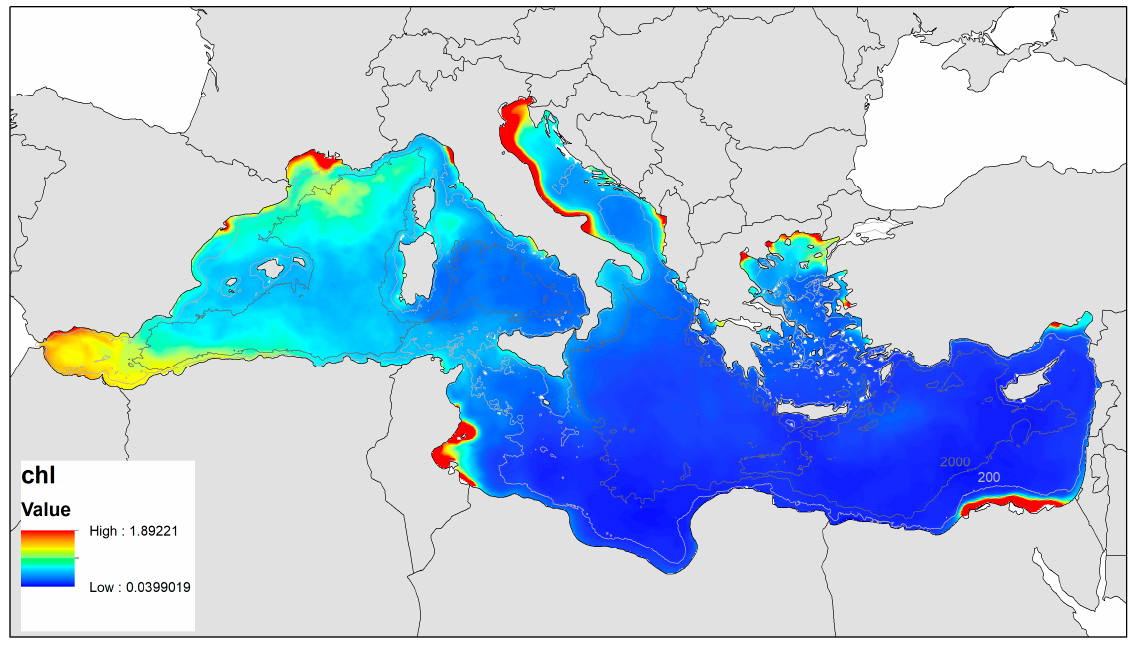
Figure 18. Chlorophyll concentration (mg.m − 3 ) (average value for 2016). Data source: https://data.marine.copernicus.eu (accessed 20 December 2022).